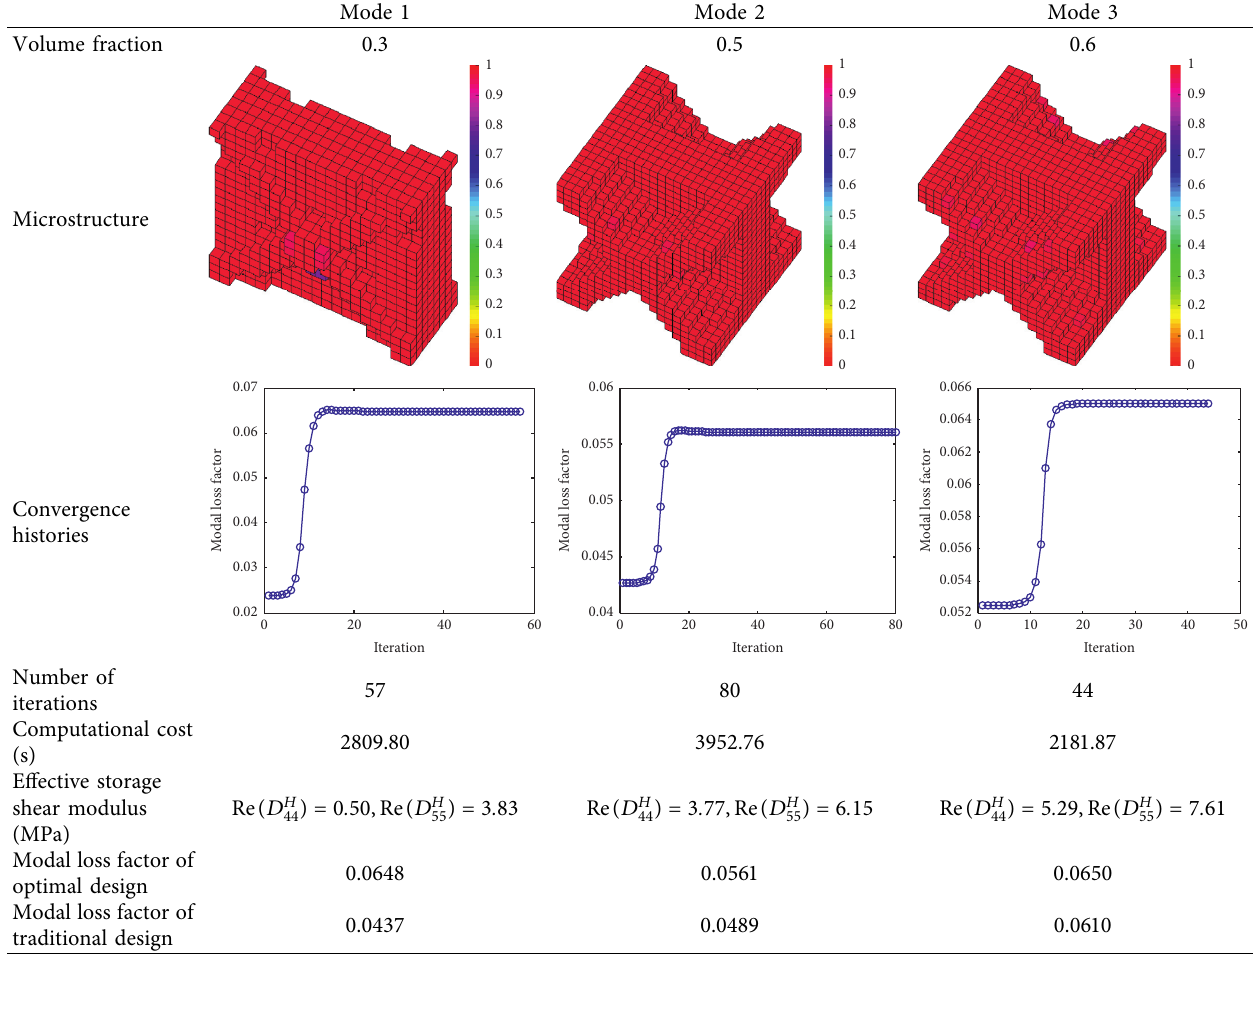
Table 6: Topological designs of viscoelastic damping material microstructures with different volume